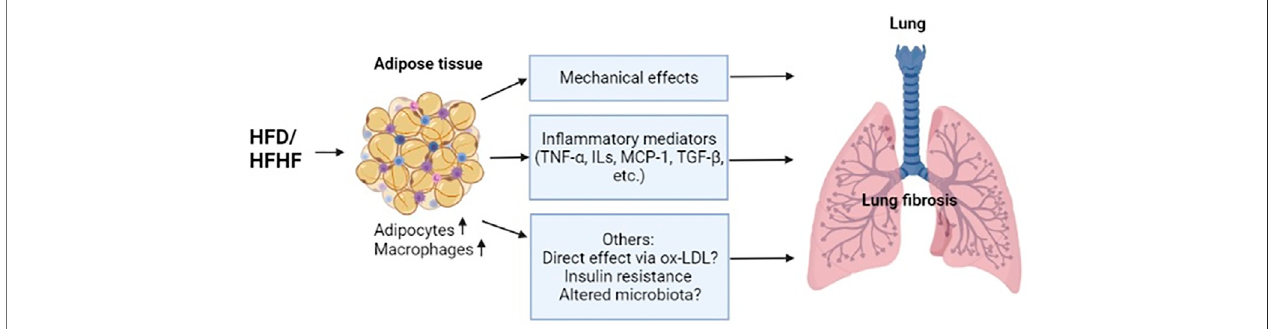
FIGURE 1 | A Proposed model of obesity caused lung fi